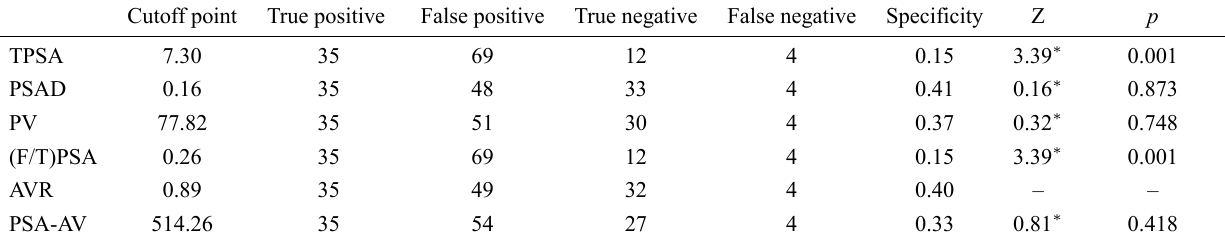
Table 5. Specificities of diagnostic parameters with high